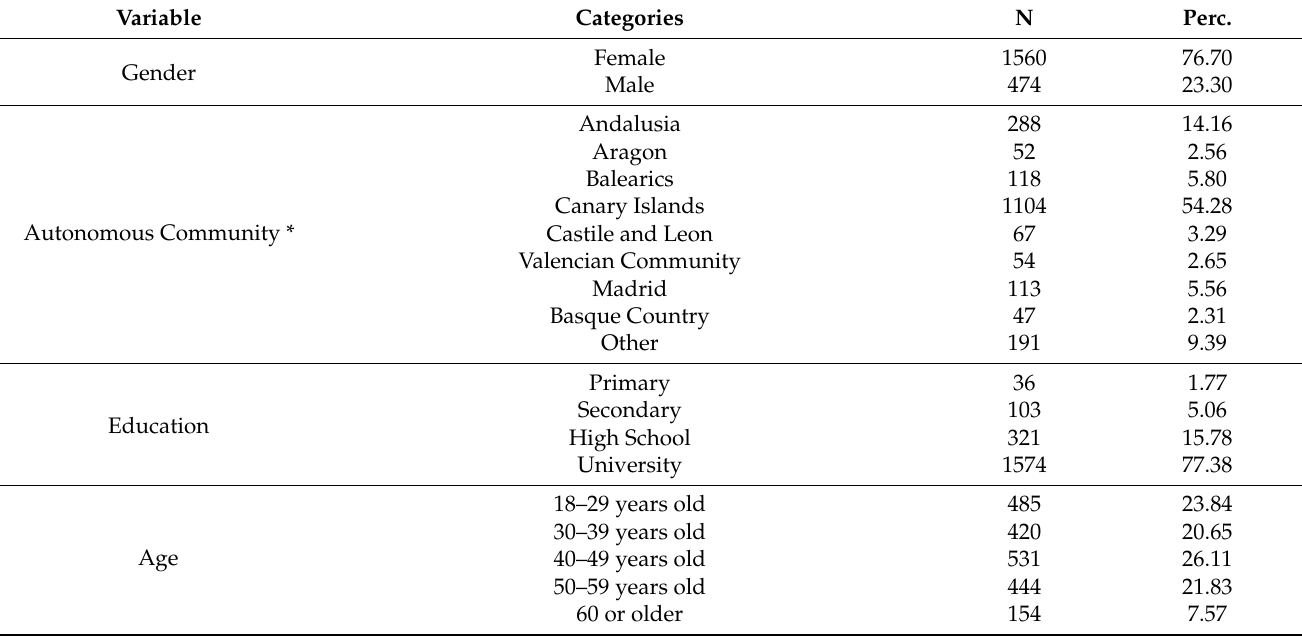
Table 3. Respondents’ sociodemographic